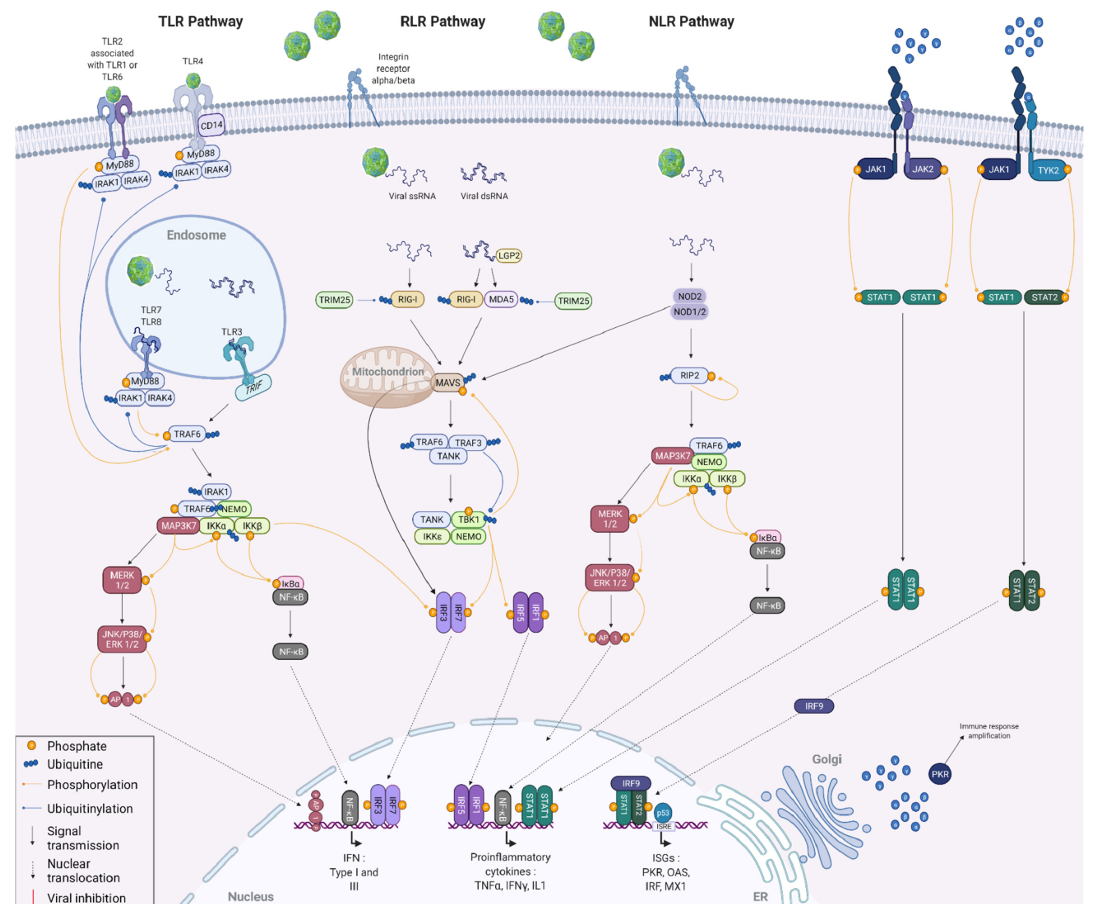
Figure 3. Innate antiviral immune responses against viral infection. The induction of the IFN response results from the recognition of characteristic viral patterns by cellular membranous or cytoplasmic receptors. Activation of these receptors triggers a signalling cascade in the cell, leading to the activation of transcription factors involved in IFN alpha and beta and proinflammatory cytokine production. Finally, the signalling phase consists of the binding of IFN-alpha and -beta to their receptors, which generates an activation signal that is propagated into the cell via the JAK/STAT pathway to enable the expression of numerous proteins with antiviral or immunomodulatory activity. Created with BioRender.com (accessed on 16 August 2022).